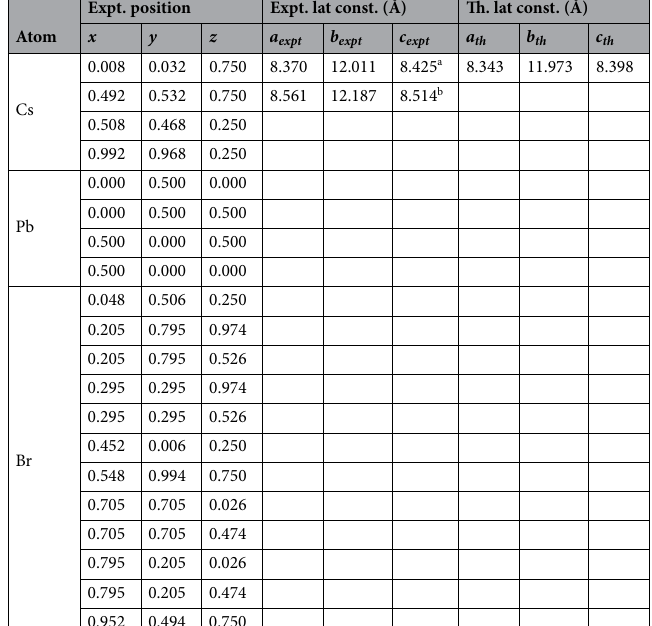
Table 1. Atomic positions, experimental lattice constants and theoretical (calculated in this work) lattice constants of orthorhombic bulk CsPbBr 3 . a 56 , b46 .